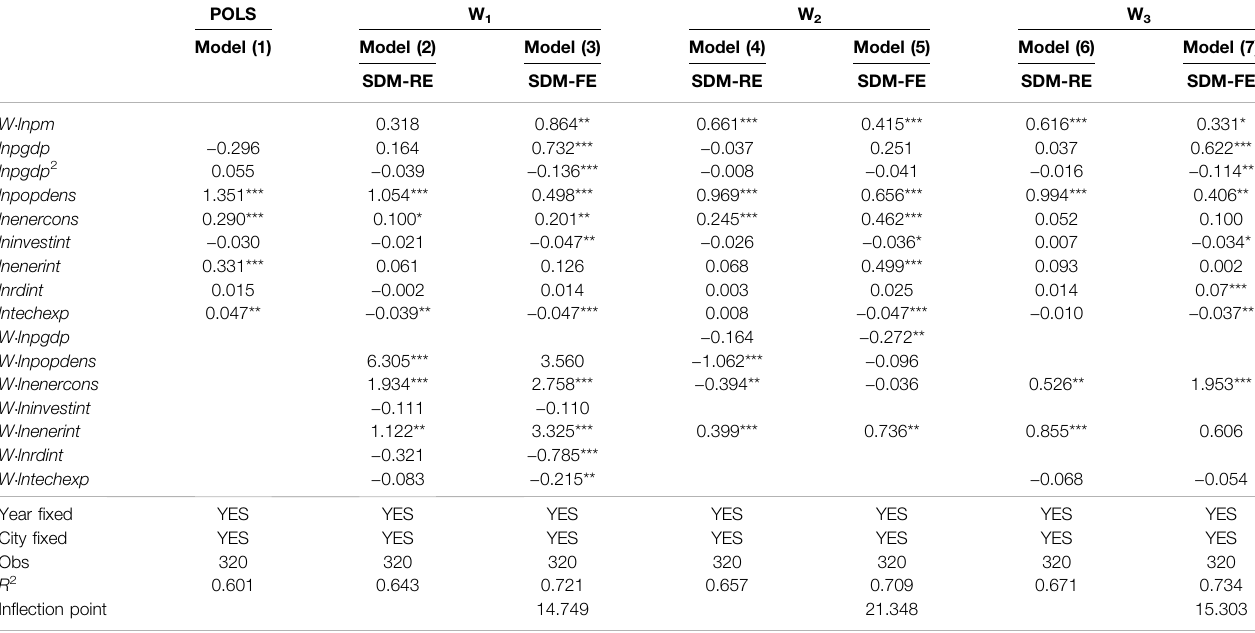
TABLE 6 | Estimation results of the spatial panel model.